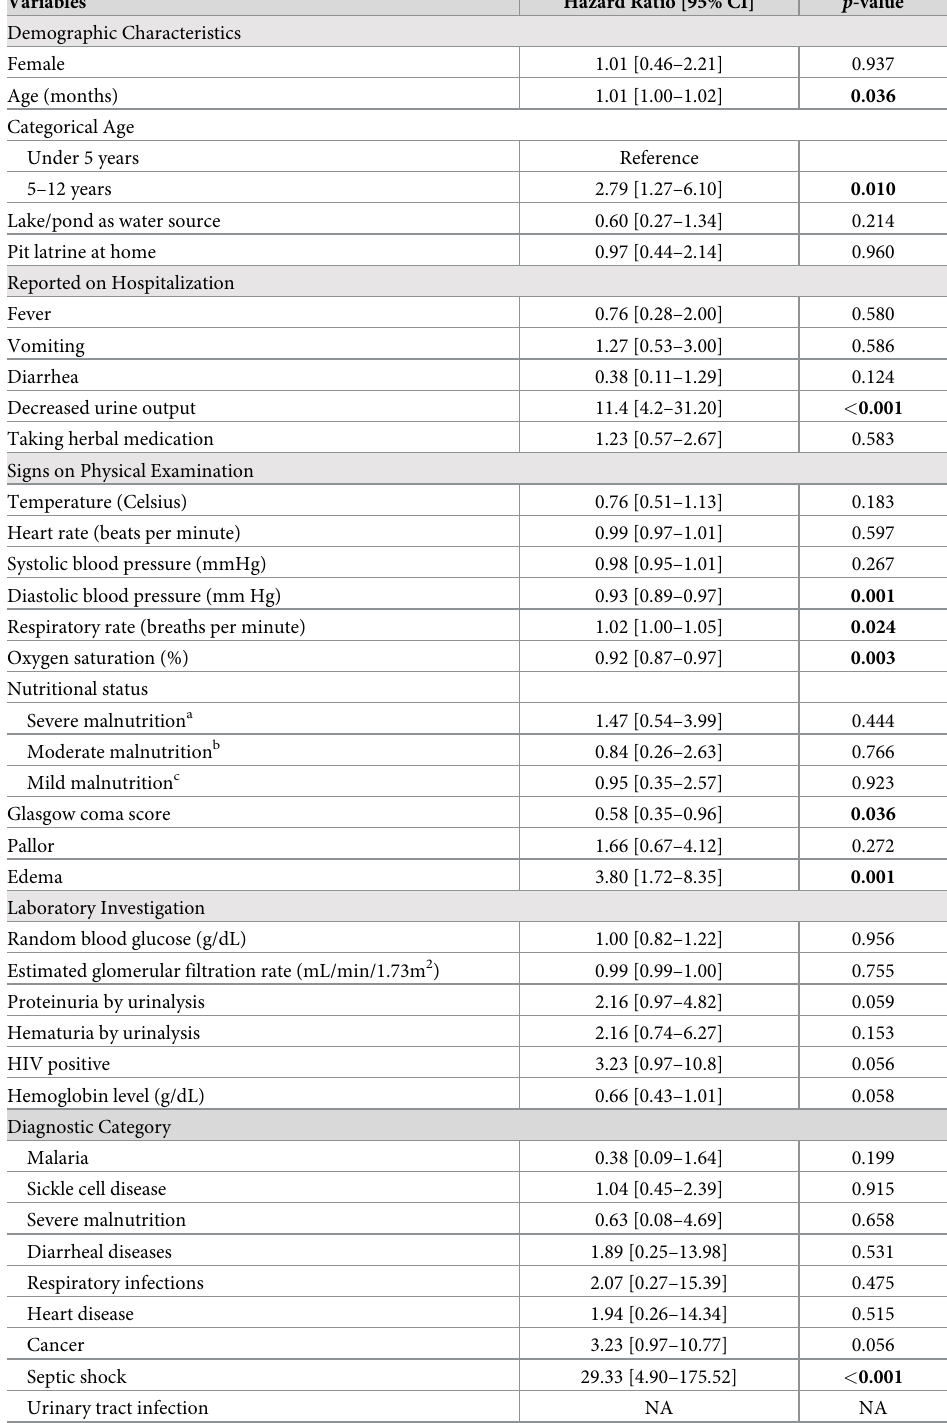
Table 3. Predictors of mortality for children with very severe anemia by univariate